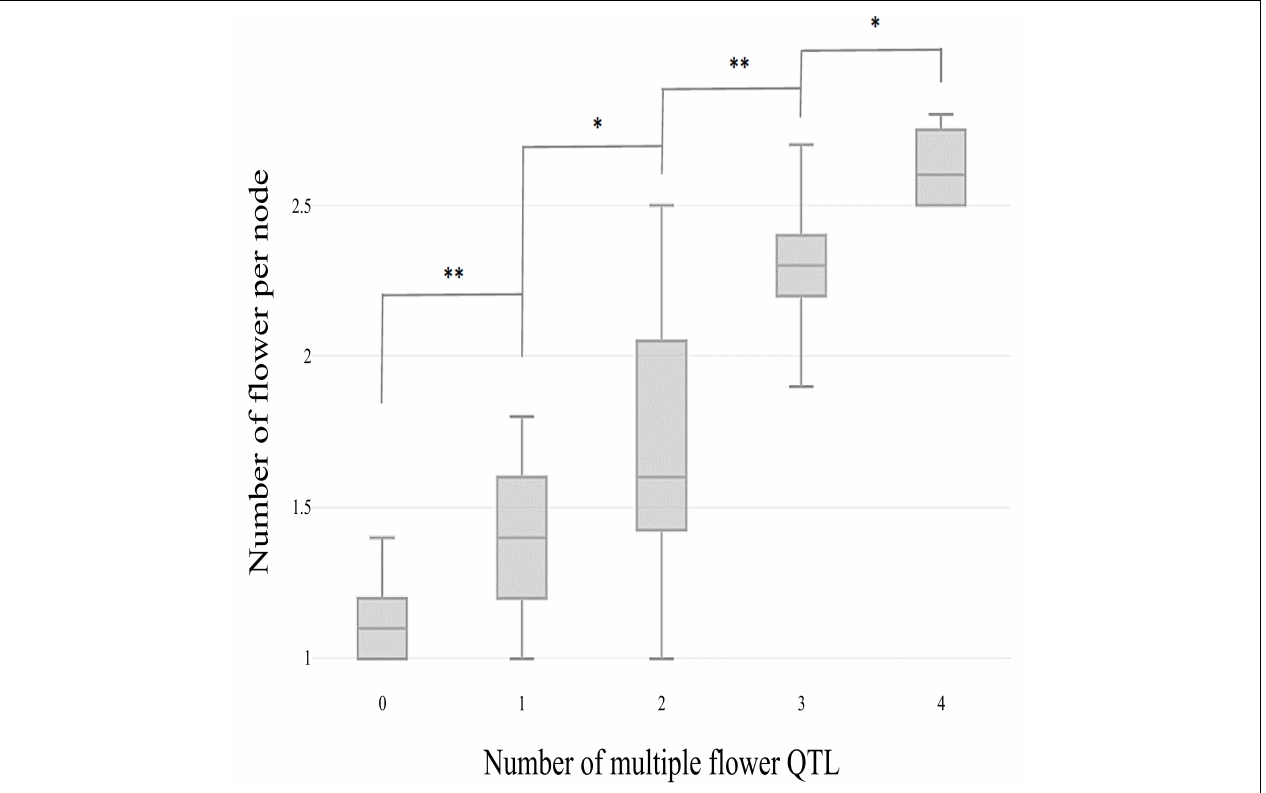
FIGURE 4 | Box plot distributions of the multiple flowers per node phenotype regulated by four TH-mf QTLs in plants from the TH RIL population. The numbers on the x -axis indicate the number of candidate QTLs homozygous for the ‘Habanero’ allele. Asterisks indicate significant differences ( ∗ P < 0.05 and ∗∗ P < 0.01). P -values were determined by a two-tailed, two-sample t